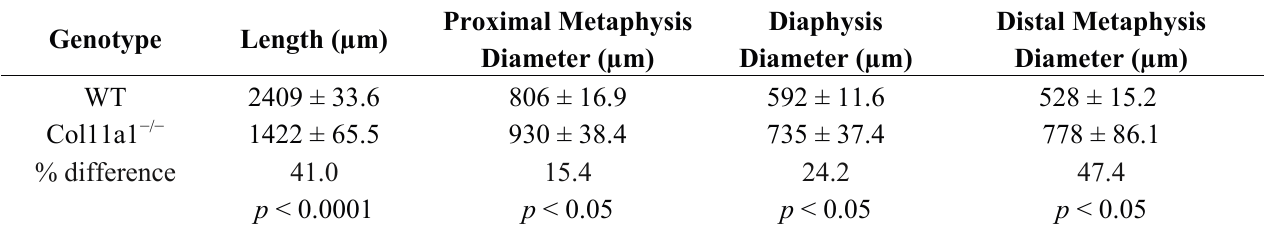
Table 3. Structural indices for humeri are reported as mean + SD for WT and Col11a1 − / − . Proximal Metaphysis Diaphysis Genotype Length (µm) Diameter (µm) WT 2409 ± 33.6 Col11a1 − / − 1422 ± 65.5 778 ± 86.1 % difference 41.0 24.2 47.4 p < 0.0001 p < 0.05 p < 0.05 p < 0.05